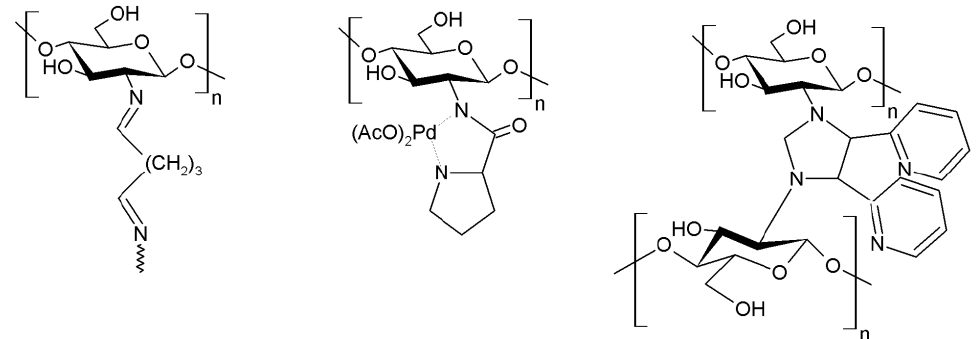
Figure 15. Some examples of chitosan-based catalysts loaded with Pd 2+ .